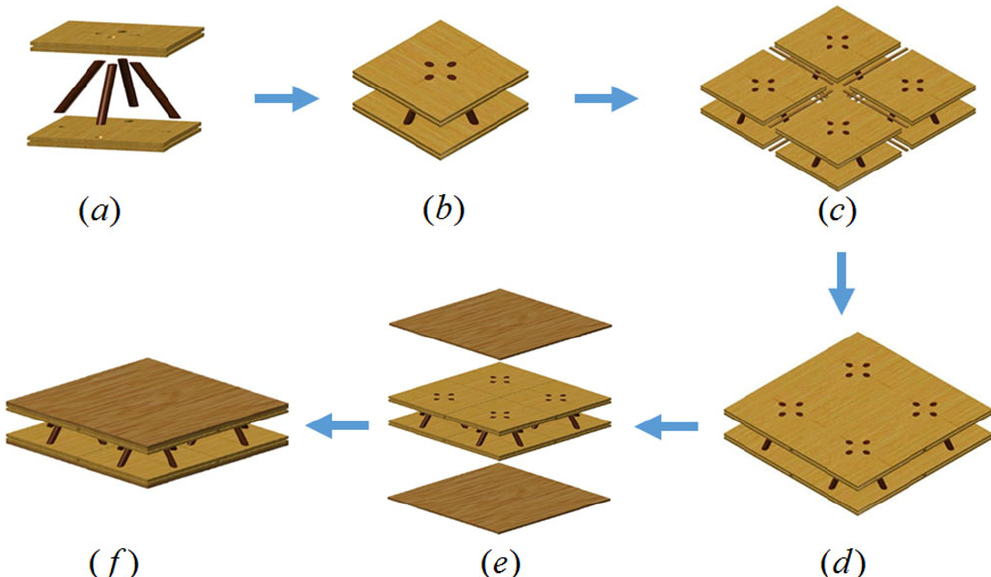
Figure 4. Lattice sandwich structure with reinforced veneer. ( a ) Drilling hole. ( b ) Adhesive bonding. ( c ) The mortise and tenon splicing method. ( d ) Prefabricated 2D wooden pyramidal lattice truss core sandwich structures. ( e ) Reinforced veneer. ( f ) Reinforced lattice 2D wooden pyramidal lattice truss core sandwich structures.